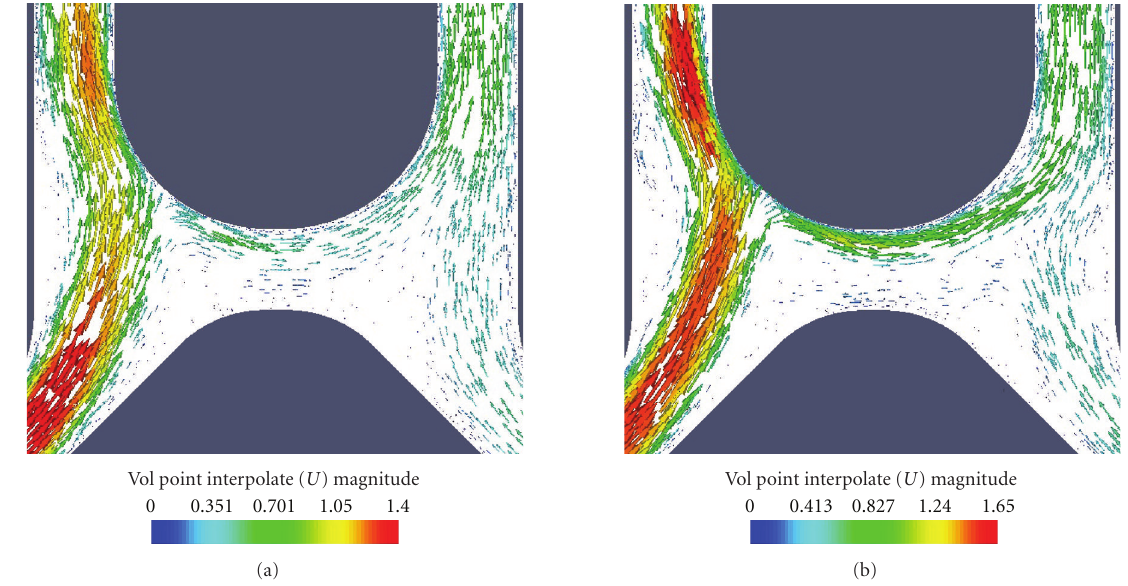
Figure 5: (a) Velocity field during systole and (b) early diastole with ACA flow rates set at Q R = 0 . 33 Q L . Again bifurcation of the A1 parent flow artery into the ACOM and A2 segments is seen. Left ACA impingement site moves further rightward along A2-ACOM adjoining wall compared to that seen in the case where Q R = 0 . 5 Q L . Flow separation is again seen on the right A2-ACOM impingement site leading to local recirculation e ff